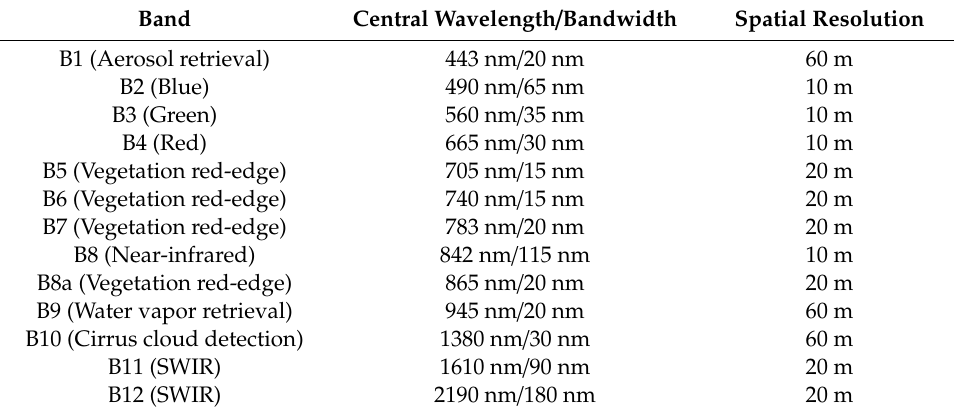
Table 1. Bands of multispectral images collected by the Sentinel-2 mission, their central wavelength, bandwidth and spatial